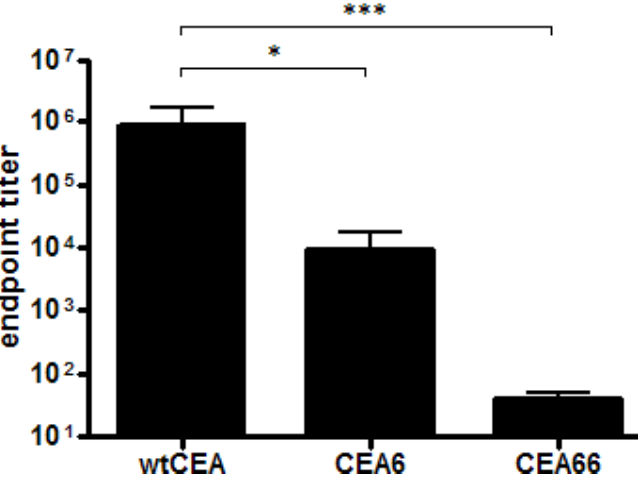
FIGURE 5. Intracellular targeting of CEA results in reduced CEA-specific antibody responses after intradermal Biojector immunization. Serum was taken 2 weeks after the third DNA immunization and subjected to a CEA ELISA. Bars show the mean endpoint titer of each group of immunized animals. * and *** indicate a statistically significant difference of p < 0.05 and p < 0.001,